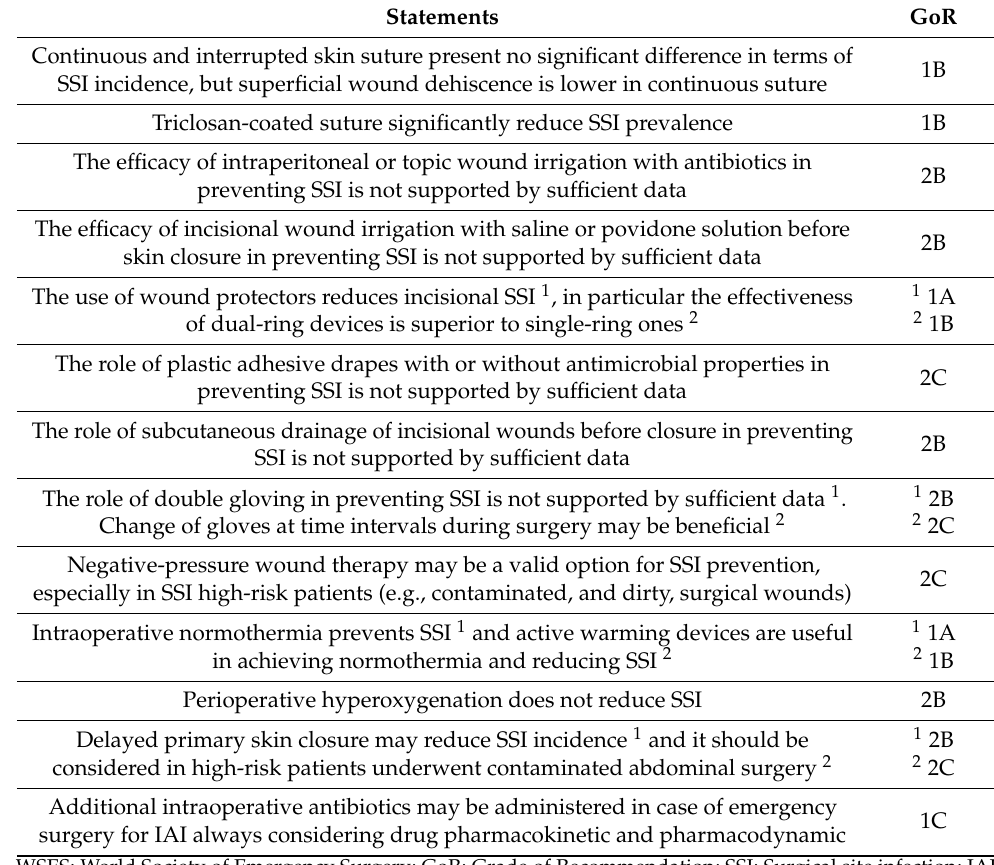
Table 4. WSES recommendations for the prevention of surgical site infection presented with the specific statements and their GRADE of supporting literature (indicated with superscript